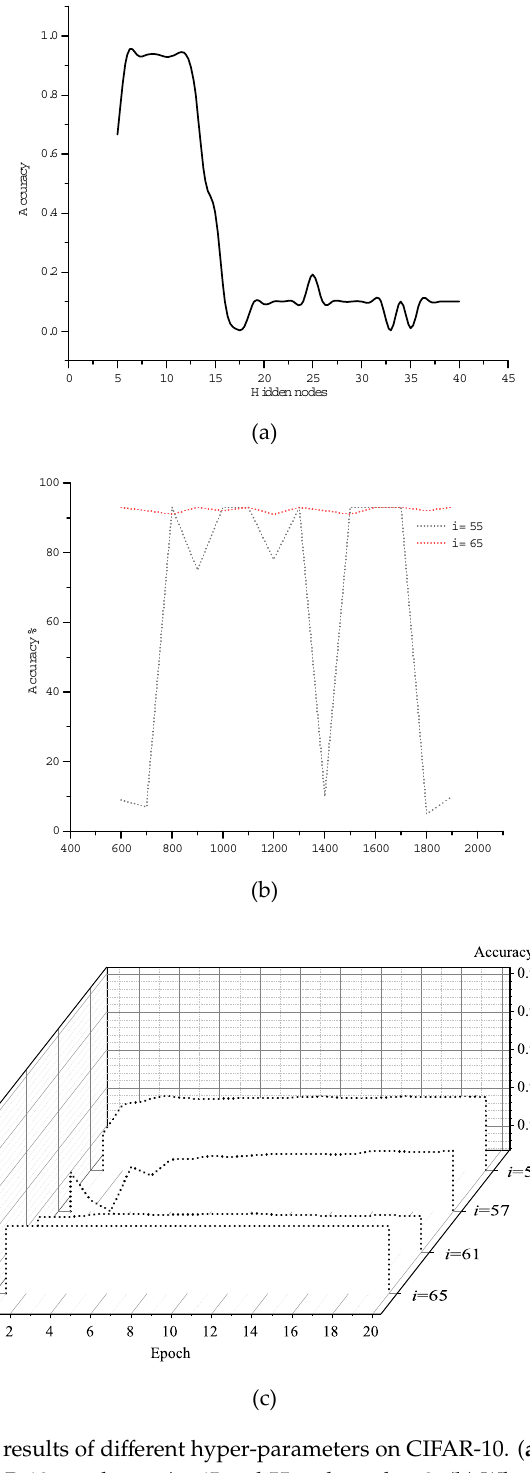
Figure 6. Experimental results of di ff erent hyper-parameters on CIFAR-10. ( a ) E ff ect of batch size on the accuracy of the CIFAR-10 test data at i = 65 and 55 and epoch = 8. ( b ) When i takes di ff erent values, the accuracy of the fnnmOS-ELM model on the test data varies with the value of epoch. ( c ) When i = 65, the accuracy varies with the number of hidden